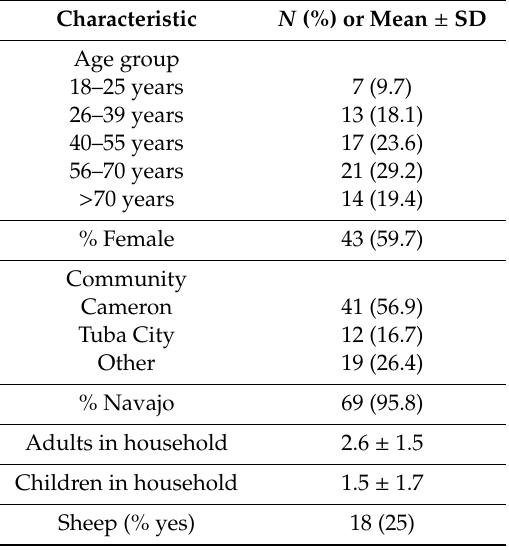
Table 1. Demographic information for participants who completed the sheep survey, 2017 ( n =